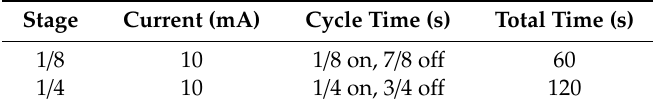
Table 1. Parameters of each stage in arc ablation resistance test.